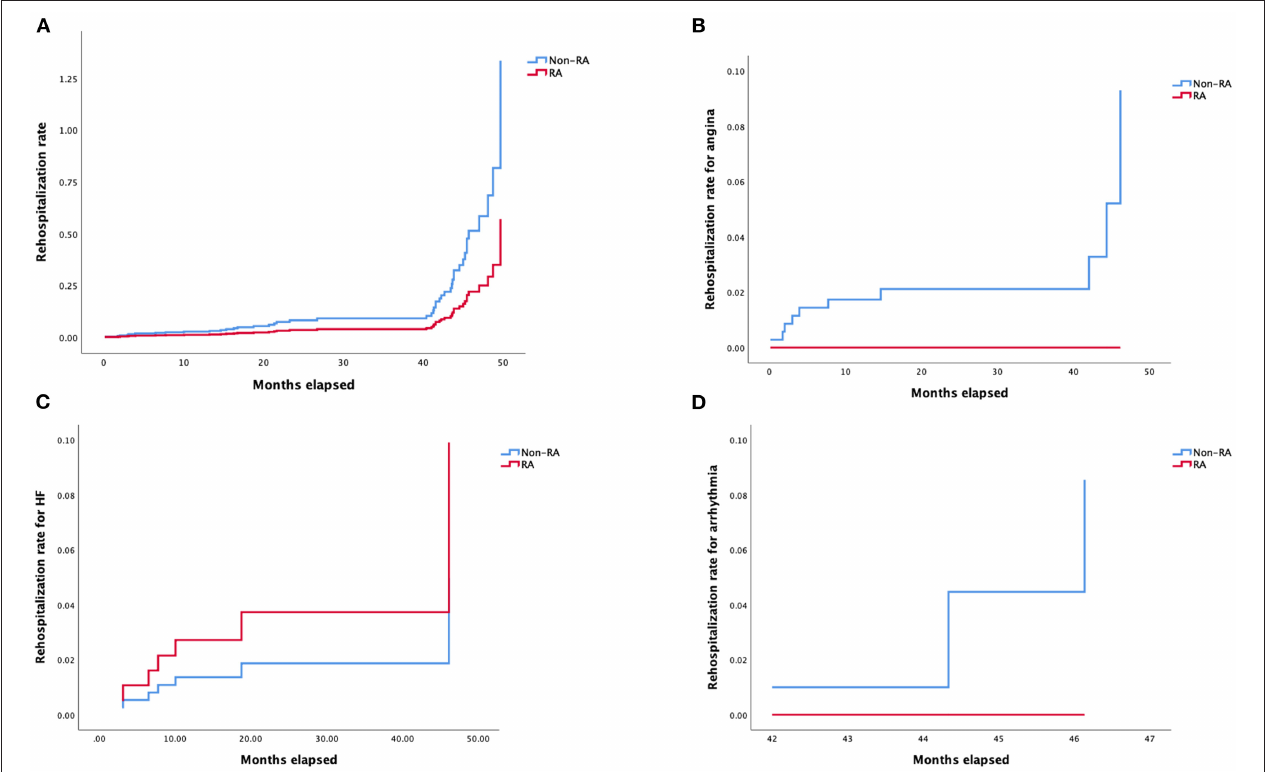
FIGURE 4 | (A) Kaplan–Meier curves of rehospitalization rate according to Cox regression model. (B) Kaplan–Meier curves of rehospitalization rate for angina according to Cox regression model. (C) Kaplan–Meier curves of rehospitalization rate for heart failure according to Cox regression model. (D) Kaplan–Meier curves of rehospitalization rate for arrhythmia according to Cox regression